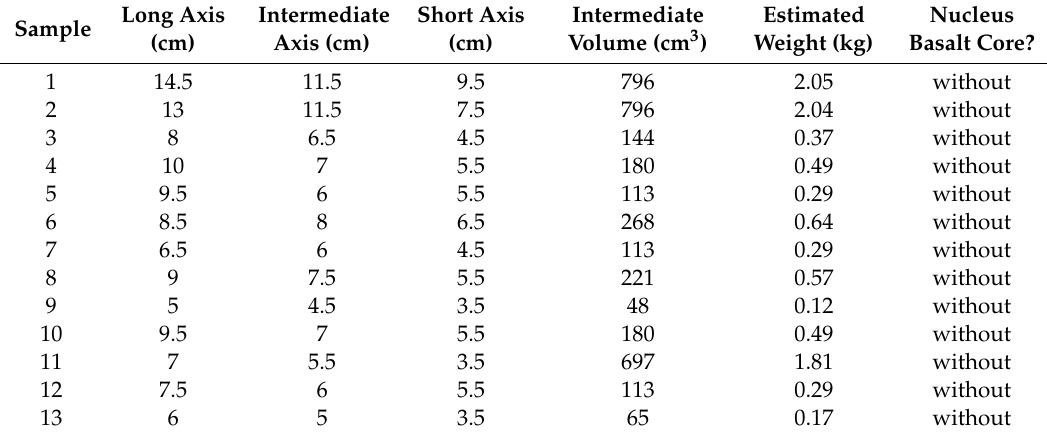
Table A1. Quantification of rhodolith size, volume, and estimated weight from Pleistocene samples at Ba í a da Parda. The density magnesium-rich limestone at 2.6 gm / cm 3 is applied uniformly in order to estimate the weight of each sample based on the radius measured against the intermediate